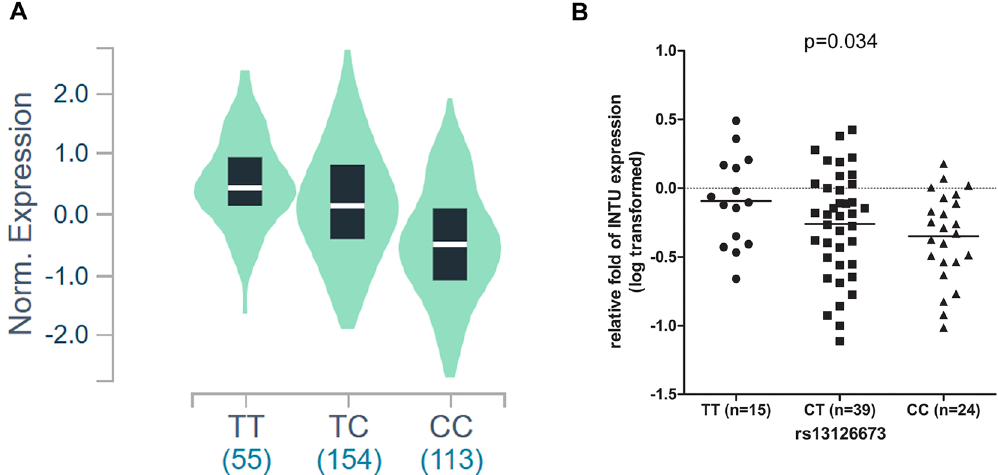
Figure 7. eQTL analysis of the normalized expression level of INTU transcripts. ( A ) SNP rs13126673 was significantly associated with INTU expression in the testis ( P = 5.1 × 10 –33 ). Expression data were extracted from GTEx v8, which contained 322 normal subjects. Of note, the individuals with CC genotype had a lower INTU expression level. ( B ) The original GWAS SNP (rs13126673) genotypes [n = 15 (TT), n = 39 (CT), n = 24 (CC)] were determined by Sequenom MassARRAY, and total RNA was extracted from the tissue. The log10 transformed expression level of mRNA for inturned planar cell polarity protein ( INTU ) was measured using reverse transcription quantitative polymerase chain reaction and normalized to that of GAPDH. The horizontal line represents mean and individual sample is represented by dots. After analysis of linear regression, the P value was 0.034.